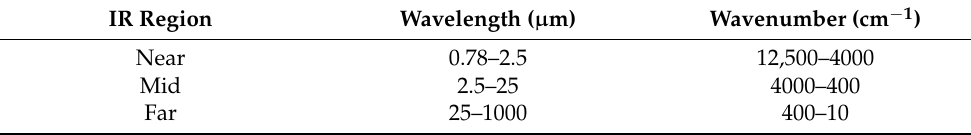
Table 1. Infrared